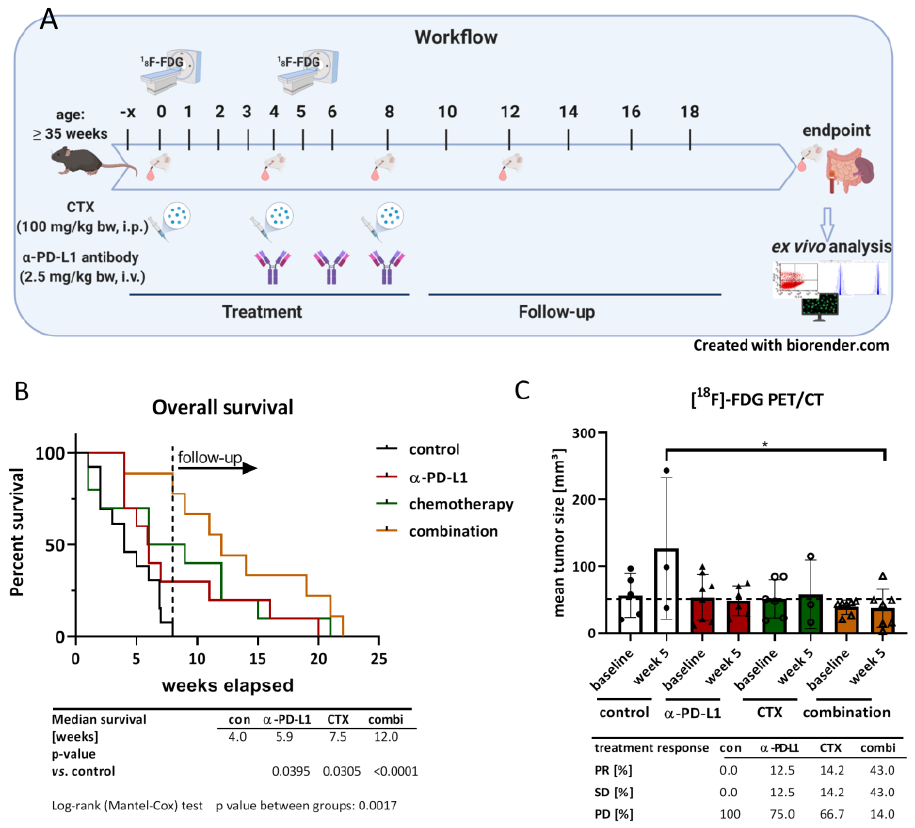
Figure 2. Therapy protocol and Kaplan-Meier survival curve. ( A ) Schematic therapeutic protocol including PET/CT imaging, blood collection and endpoint procedure. ( B ) Kaplan-Meier survival curve. Mice were treated with α -PD-L1 (clone 6E11, Genentech, 2.5 mg/kg bw, i.v., q2w), gemcitabine (100 mg/kg bw, i.p., q4wx3, CTX = chemotherapy), or a combination of chemotherapy, followed by α -PD-L1 antibody therapy four weeks later. ( C ) Tumor progression under therapy, measured with [18F] FDG PET/CT. The mean tumor volume ± SD in mm 3 are shown. Measurements were taken at start of the respective therapy and 5 weeks later (n = 3–8 mice/group and time-point). * p < 0.05; one-way ANOVA (Dunnett’s multiple comparison